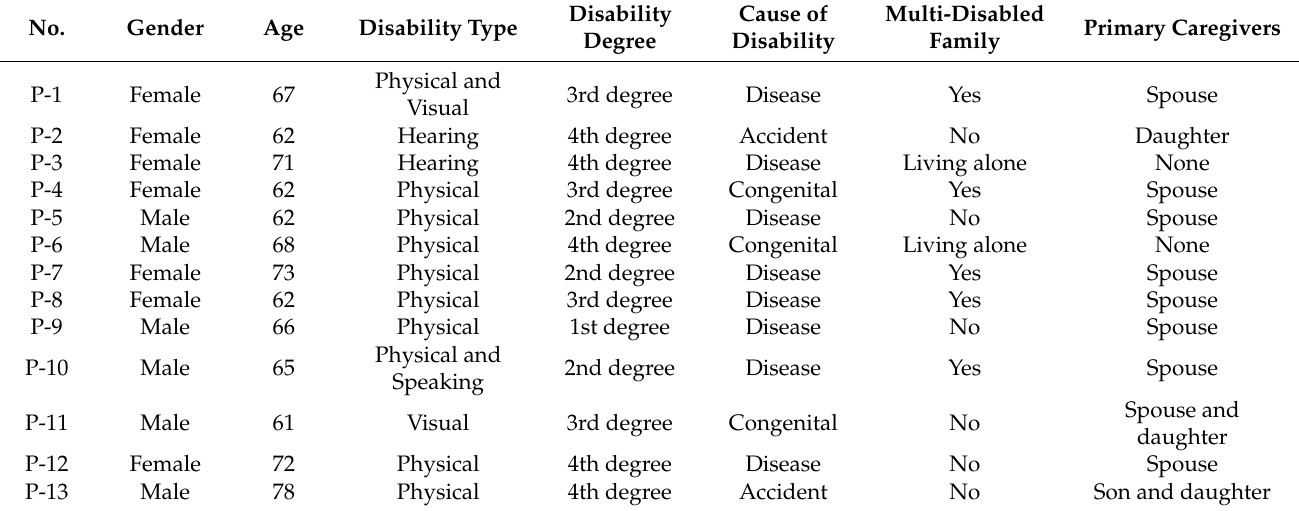
Table 1. Description of research